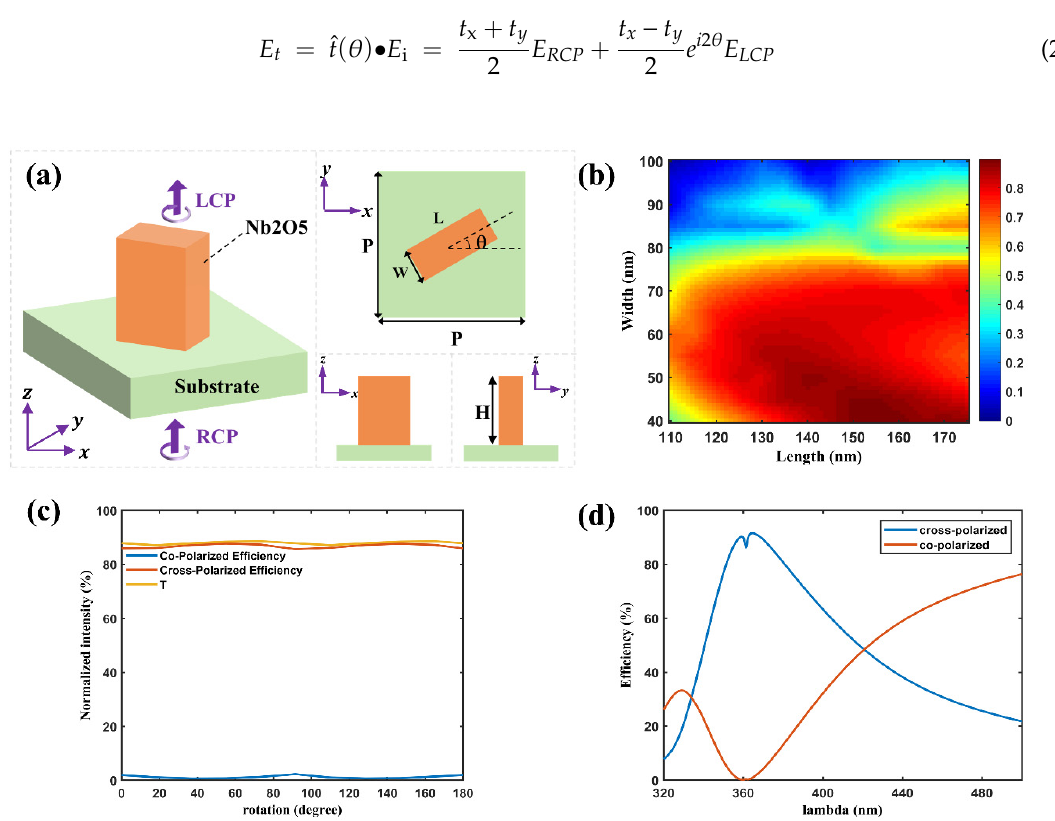
Figure 1. The optical properties of the Nb 2 O 5 -based meta-atom. ( a ) Sketch of the Nb 2 O 5 nanobar with a rotation angle of θ on the silica substrate. This meta-atom is designed to convert the incident right-handed circular polarization (RCP) plane wave into the transmitted left-handed circular polarization (LCP) wave with an additional phase modulation of e i 2 θ . ( b ) Simulated conversion e ffi ciency η for the nanobar with optimized height H = 340 nm, period P = 200 nm, and various lengths L and widths W under the RCP wave incidence at 355 nm. ( c ) The transmission (orange line), co-polarized (RCP, blue line), and cross-polarized (LCP, red line) e ffi ciencies versus rotation angle θ of the Nb 2 O 5 nanobar arrays under the RCP wave incidence at 355 nm. ( d ) The transmitted co-polarized and cross-polarized e ffi ciencies of the optimized meta-atom arrays are investigated within a broadband wavelength range.